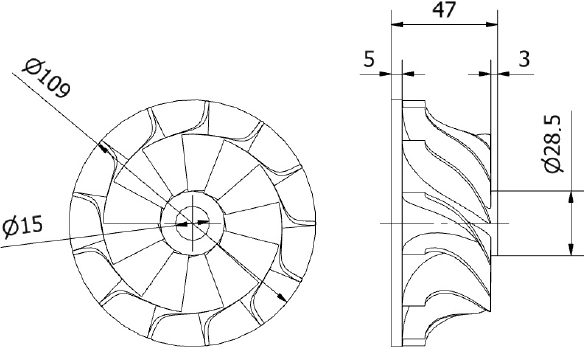
and Young’s modulus but also have a low density (which results from equations 14-16). As can be seen in Figure 9, the yield strength is not a constant value, but it decreases with temperature. Si 3 N 4 has the highest yield strength at 20 ∘ C, which decreases with increasing temperature. Alu- mina and silicon carbide also have quite good properties at temperatures of up to 800 ∘ C.